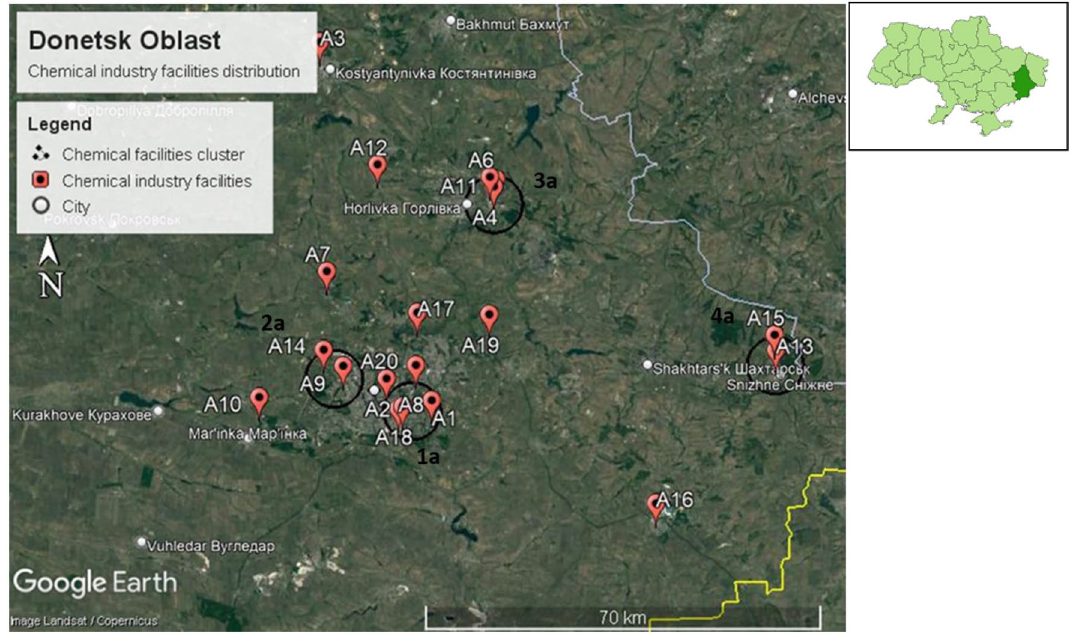
Figure 8. Four chemical facilities cluster identified in Donetsk